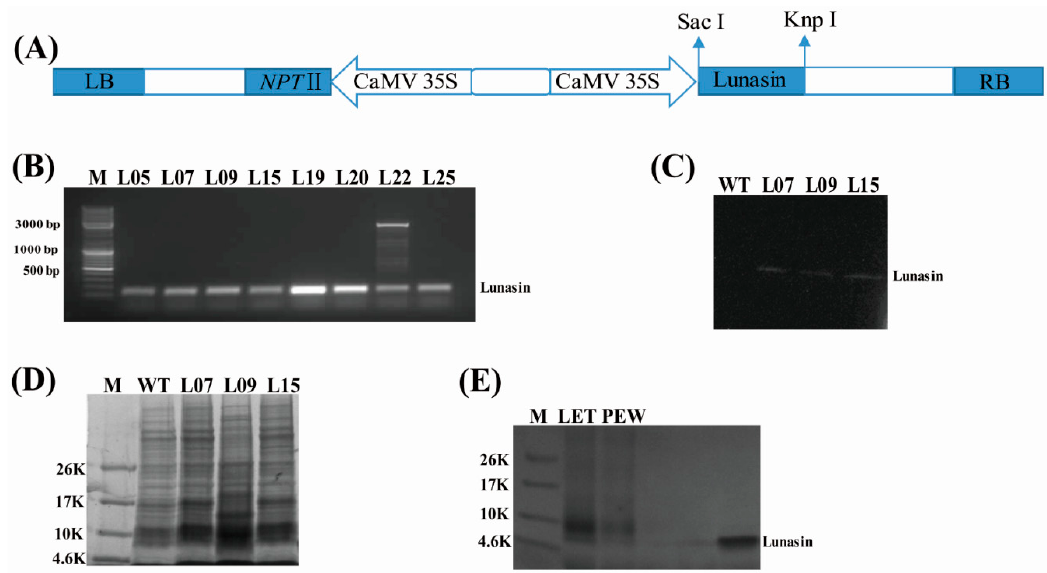
Figure 1. Construction of plasmid and molecular analysis of trans-lunasin rice. ( A ) T-DNA region of the plasmid PCAMBIA2301 for transformation. Lunasin was controlled by the CaMV35S promoter. RB: T-DNA right border. LB: T-DNA left border. ( B ) PCR demonstration of different transgenic rice lines. ( C ) Western blot analysis in the trans-lunasinrice lines. ( D ) Total protein was separated in a 12% polyacrylamide gel. ( E ) 4–20% SDS-PAGE of lunasin-enriched fractionfrom trans-lunasin rice (LET) and PEW (peptide-enriched fraction from wild type rice).